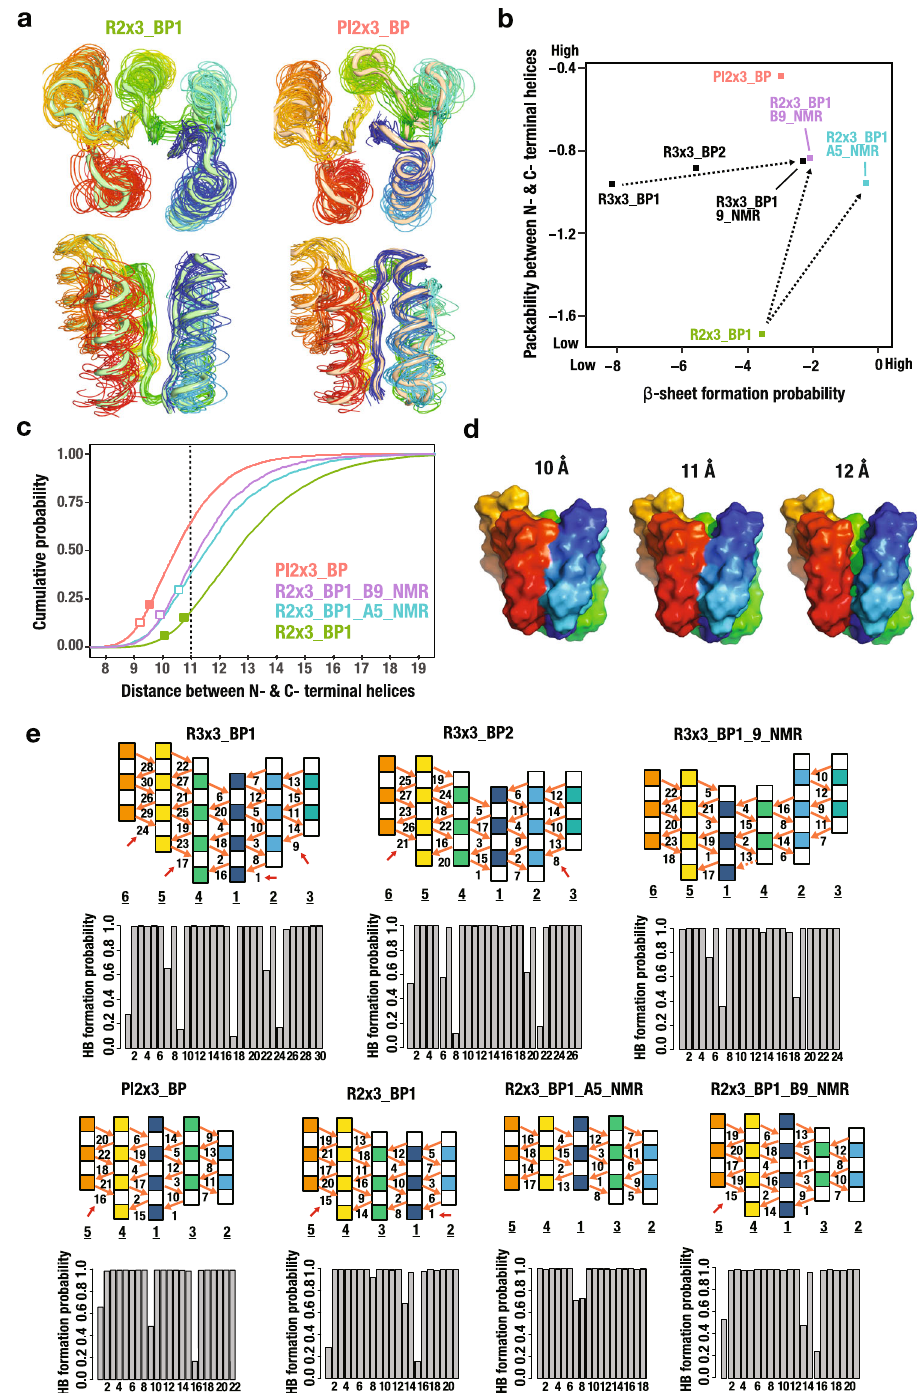
Fig. 5 Increased structural frustration in backbone ensembles generated from original design blueprints. a Backbone structure ensembles generated from blueprints for R2×3_BP1 and Pl2×3_BP. Individual members of the ensembles are represented by wireframe and averages over the thousands of backbones generated for each blueprint, in tubes. b The β -sheet formation probability and packability between the N- and C- terminal helices for the blueprints used in the designs and the strand-swapped NMR-structure-based blueprints. c Cumulative probability distributions of the distance between the N- and C- terminal helices for Pl2×3_BP, R2×3_BP1_A5_NMR, R2×3_BP1_B9_NMR, and R2×3_BP1. Filled boxes represent the distances of design models and open boxes, those of NMR structures. d Structures generated from R2×3_BP1 with the distance between the N- and C- terminal helices 10, 11, and 12 Å demonstrate that close helix packing is achieved at less than ~11 Å (for visualization, valine side chains are placed on the backbones at all residue positions). e (top) Schematic diagrams of hydrogen bonds in the parallel β -sheets of the designs and NMR structures. (bottom) Hydrogen-bond (HB) formation probability for each hydrogen bond (The numbering in the bar graph corresponds to that shown in the β -sheet schematics). Red arrows show the incomplete hydrogen bonds, in which donor is provided by the fi rst residue of the strands. The dotted hydrogen bond in R3×3_BP1_9_NMR was not included because this bond is broken both in the NMR structures and the simulation